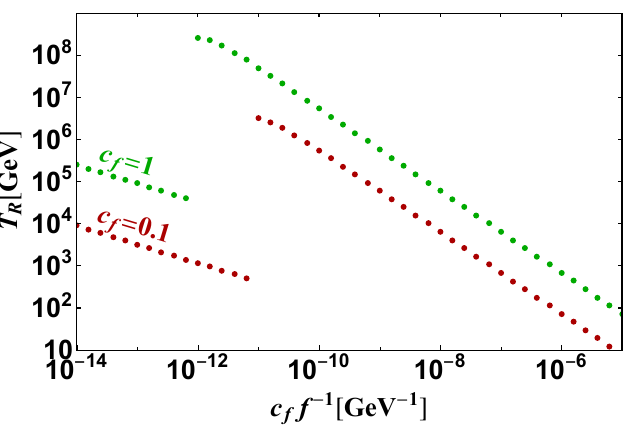
Figure 6 . The reheating temperature of the ALP in(cid:13)ation ( n = 2) with coupling to the SM fermions as a function of, c (cid:0) 1 f . The green (upper) and red (lower) points represent the cases with f a universal coupling c f = 1, and 0 : 1,